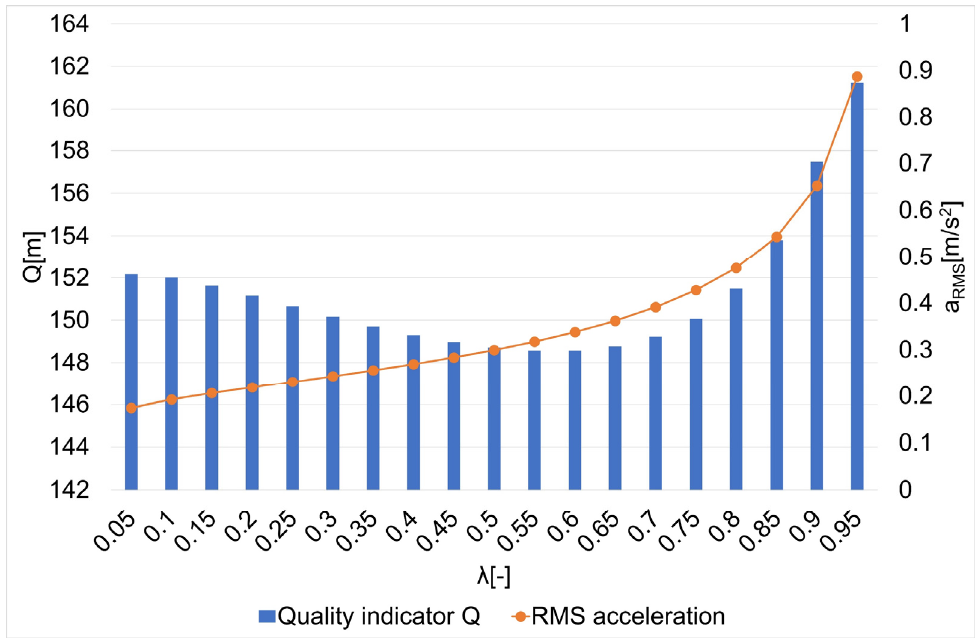
Figure 9. The values of the quality indicator Q and the mean square value of acceleration a RMS for the smoothing parameters in the case of path no. 5 [6].